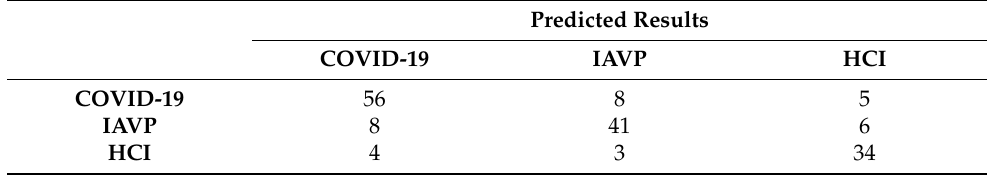
Table 5. Confusion matrix of COVID-19, IAVP, and